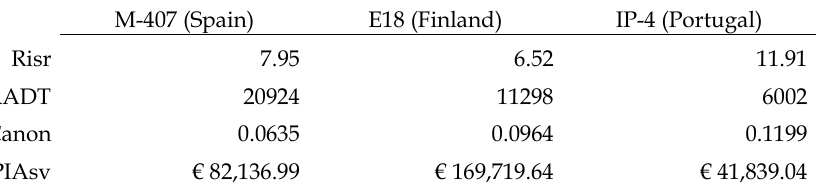
Figure 5. Formulation of road safety incentives included in the selected concessions Table 3. Breakdown of the introduction of Road Safety